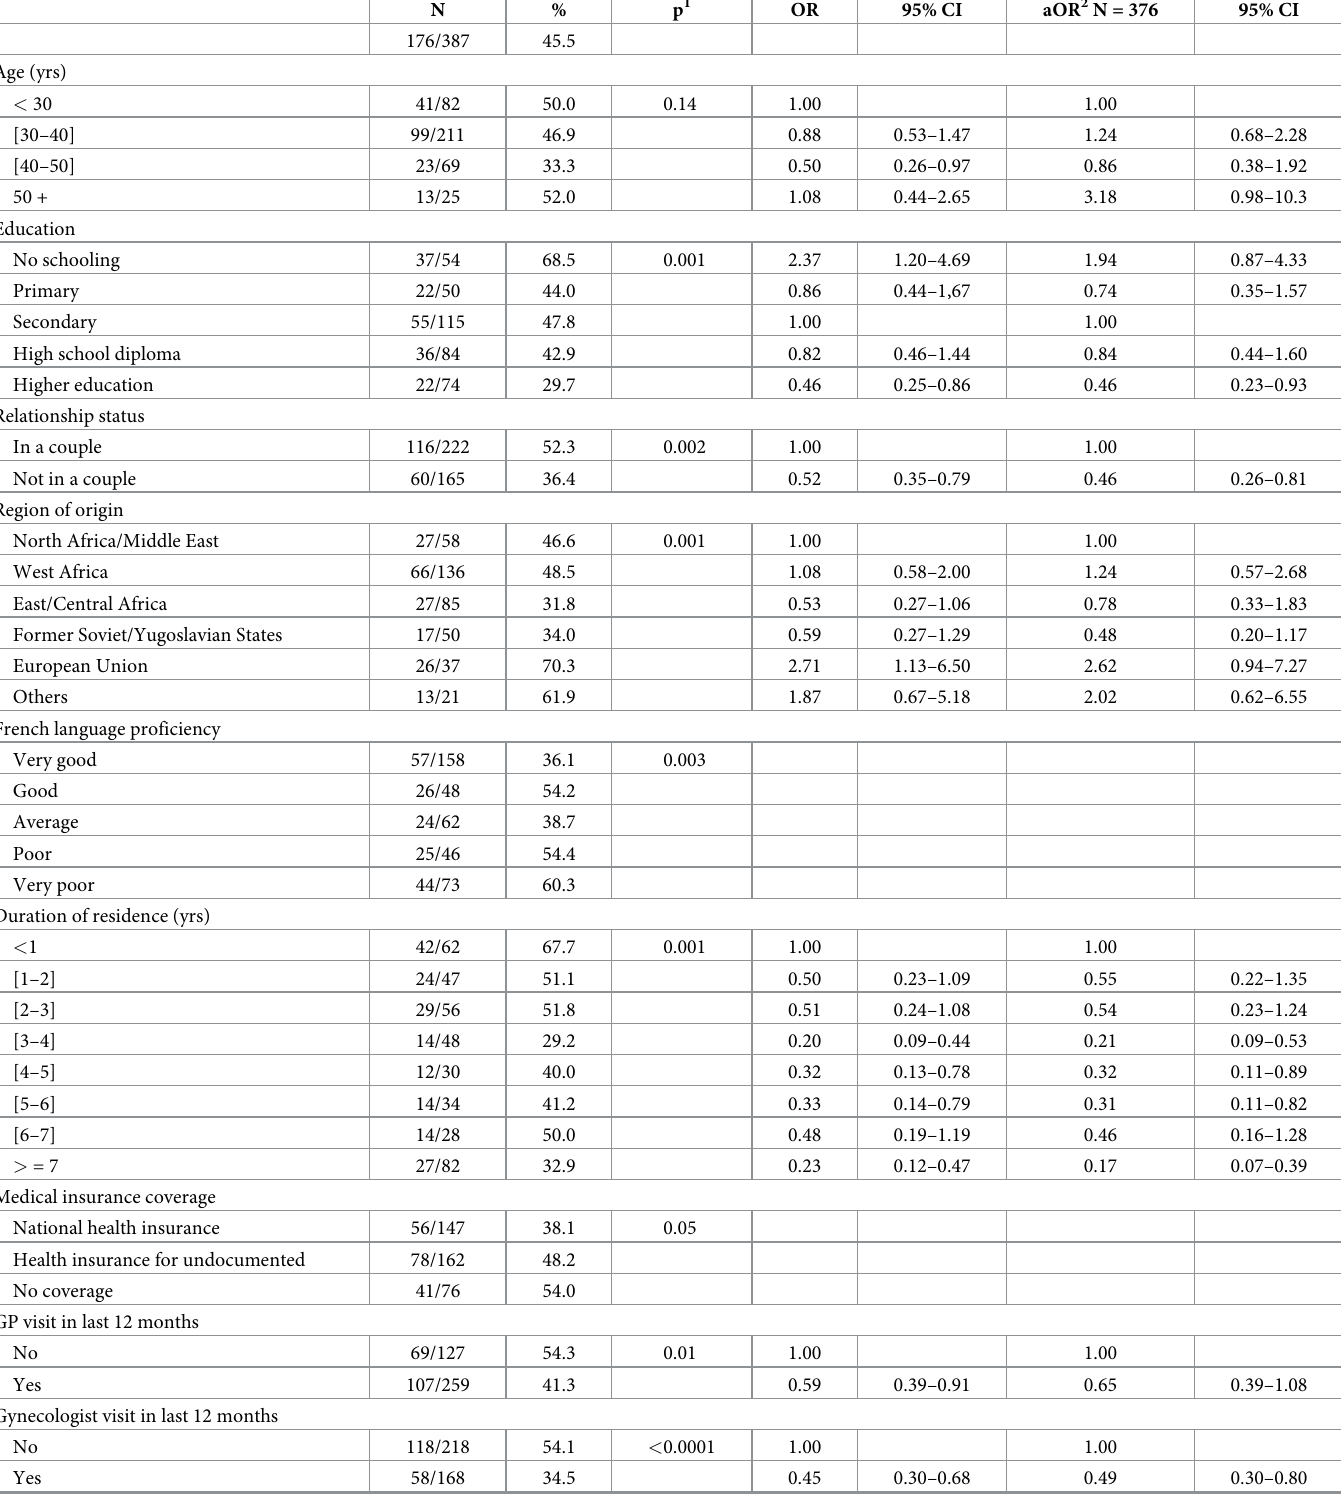
Table 2. Characteristics associated with no lifetime cervical cancer screening, bivariate and multivariate analyses, DSAFHIR